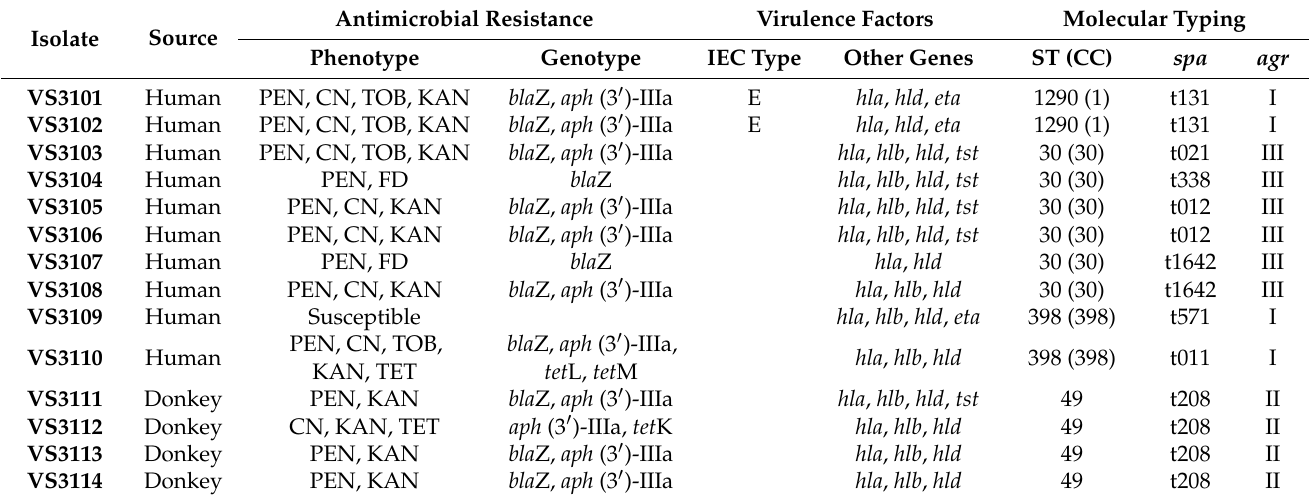
Table 1. Genetic characterization and molecular typing of S. aureus strains recovered from donkeys and their